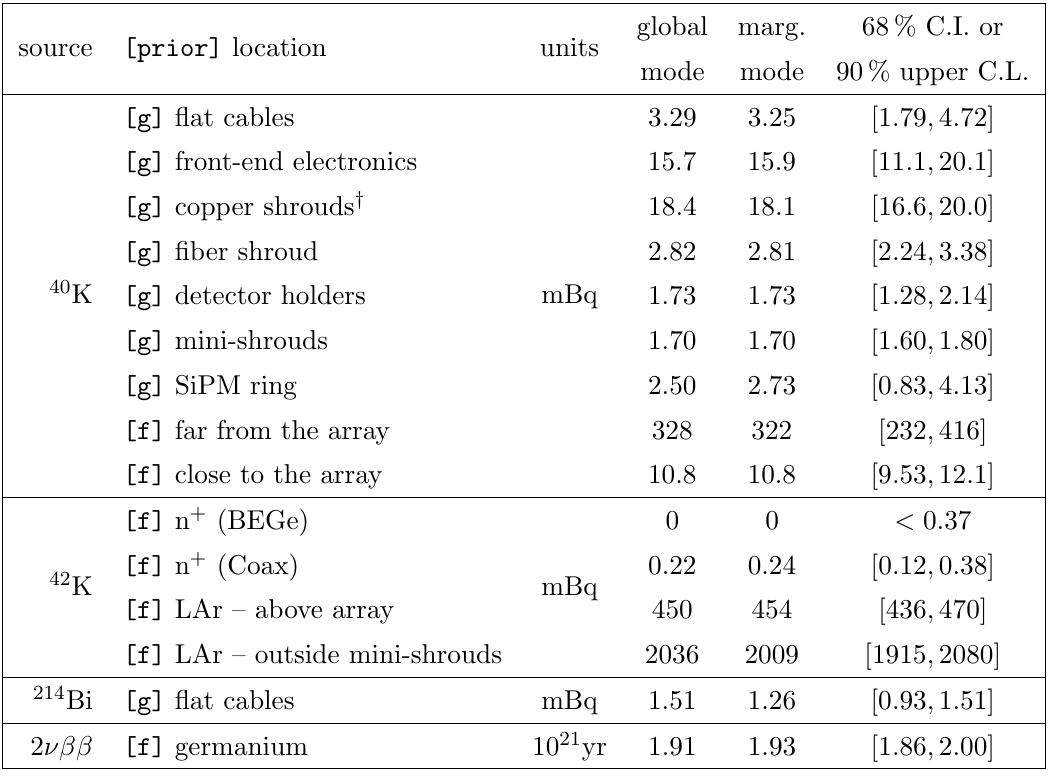
Table 5. Summary of the (cid:12)t parameters estimated with the potassium source tracking analysis (base model). The type of prior distribution is indicated with [f] : (cid:13)at, [g] : Gaussian.